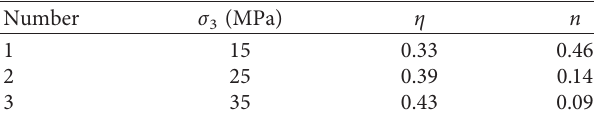
0 ; (b) different m . Table 2: Parameters related to correction